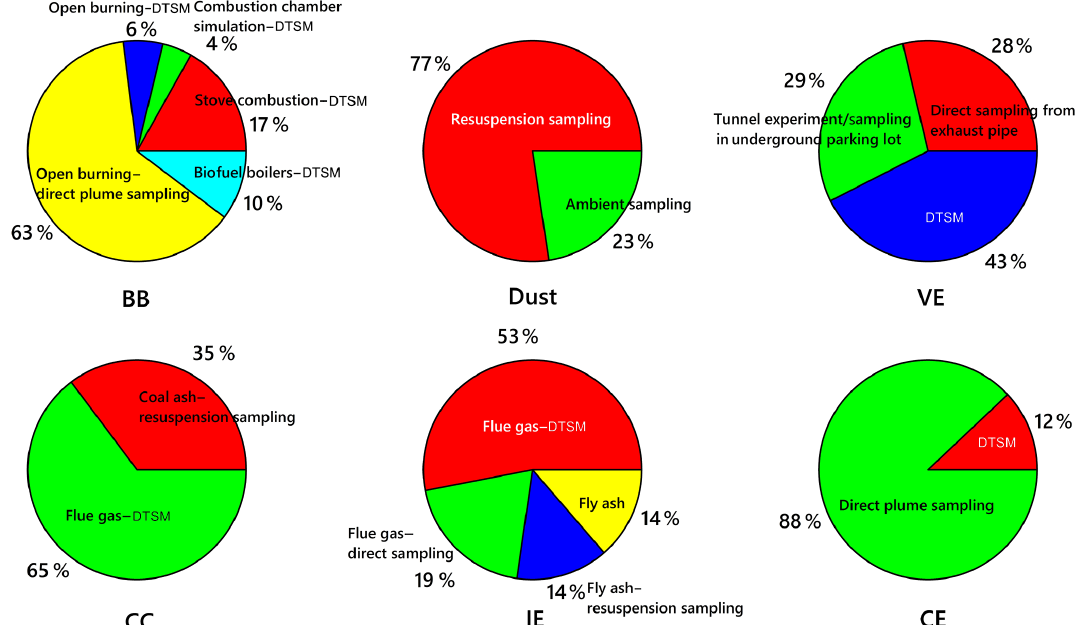
Figure 2. Distribution of sampling methods for samples of each source type in China acquired from literature. DTSM represents the dilution tunnel sampling